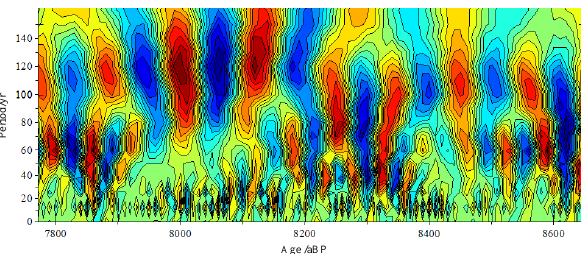
Fig. 7. The time-frequency representation of the real part of com- plex Morlet wavelet coefficients for decadal-scale periods of the Nuanhe δ 18 O record during 8.6 ∼ 7.8kaBP. The method is avail- able at http://atoc.colorado.edu/research/wavelets. X-axis indicates age (a BP), while Y-axis represents the Fourier period (yr). The do- main periods are 20yr and 100yr over the whole